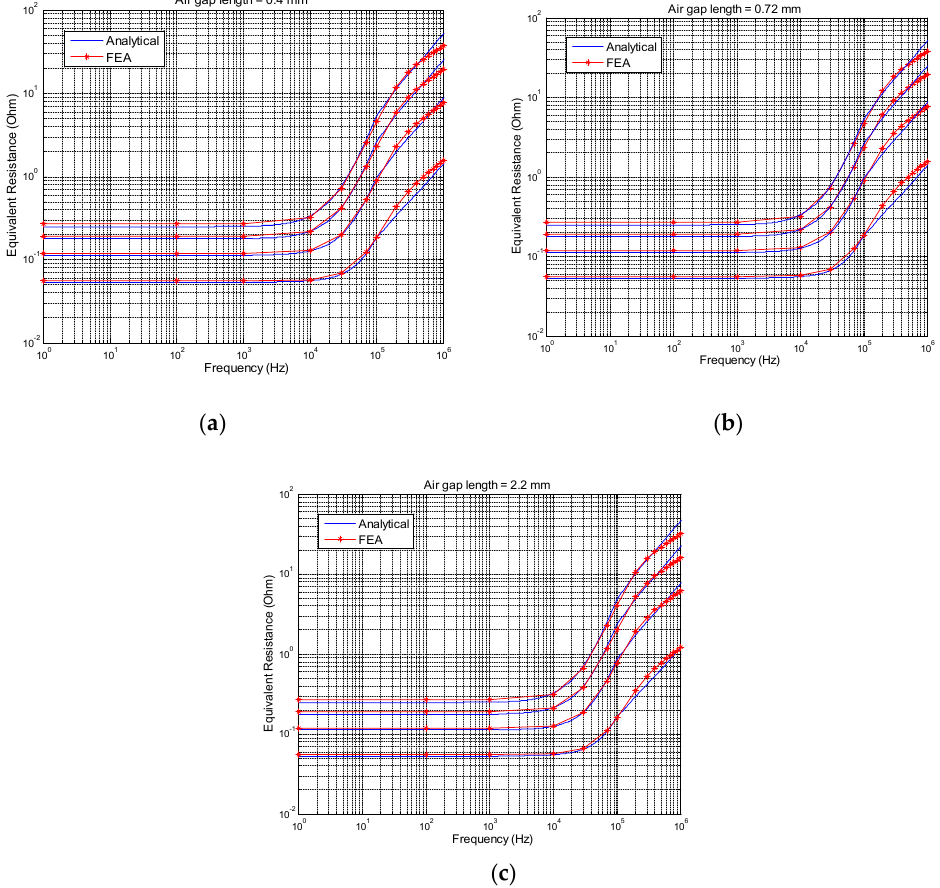
Figure 10. Equivalent resistance vs. frequency of the inductors in Figure 9. Comparison of the ana- lytical and FEA results for components with 1 to 4 layers (15 to 60 turns) with 0.4 mm, 0.72 mm, and 2.2 mm in ( a ), ( b ), and ( c ), respectively.